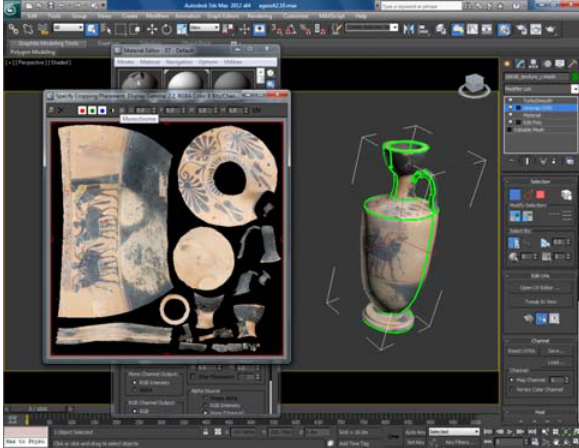
Fig. 10. Final processing of the 3D textured model of the bigger